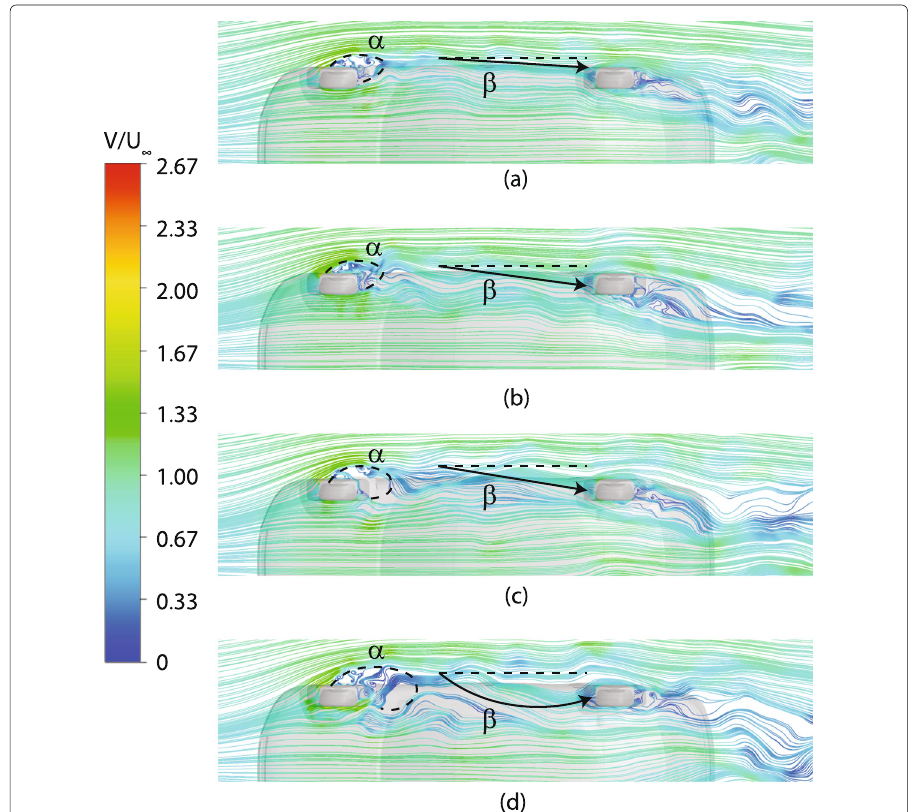
Fig. 17 Surface streamlines, colored by dimensionless velocity magnitude, at z = 50 mm above the ground plane for U ∞ = 15 m/s ( a ) baseline, ( b ) 90 ◦ air jet with U = 1/3, ( c ) 90 ◦ air jet with U = 3/3, and ( d ) 90 ◦ air jet with U = 6/3